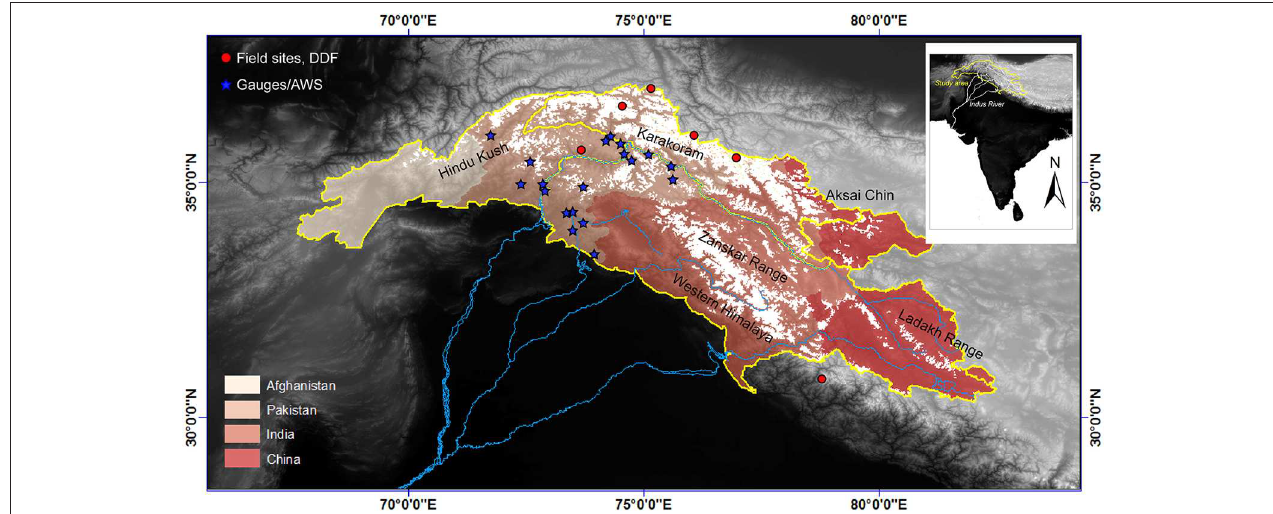
FIGURE 1 | Location of glaciated portion of the upper Indus River watershed (in white) and key mountain ranges. Indus watershed as defined by Global Runoff Data Center. Also noted are the locations of all publicly available meteorological stations and streamflow data in the region (blue stars), and those glaciers where degree-day melt factors have been measured (red dots).